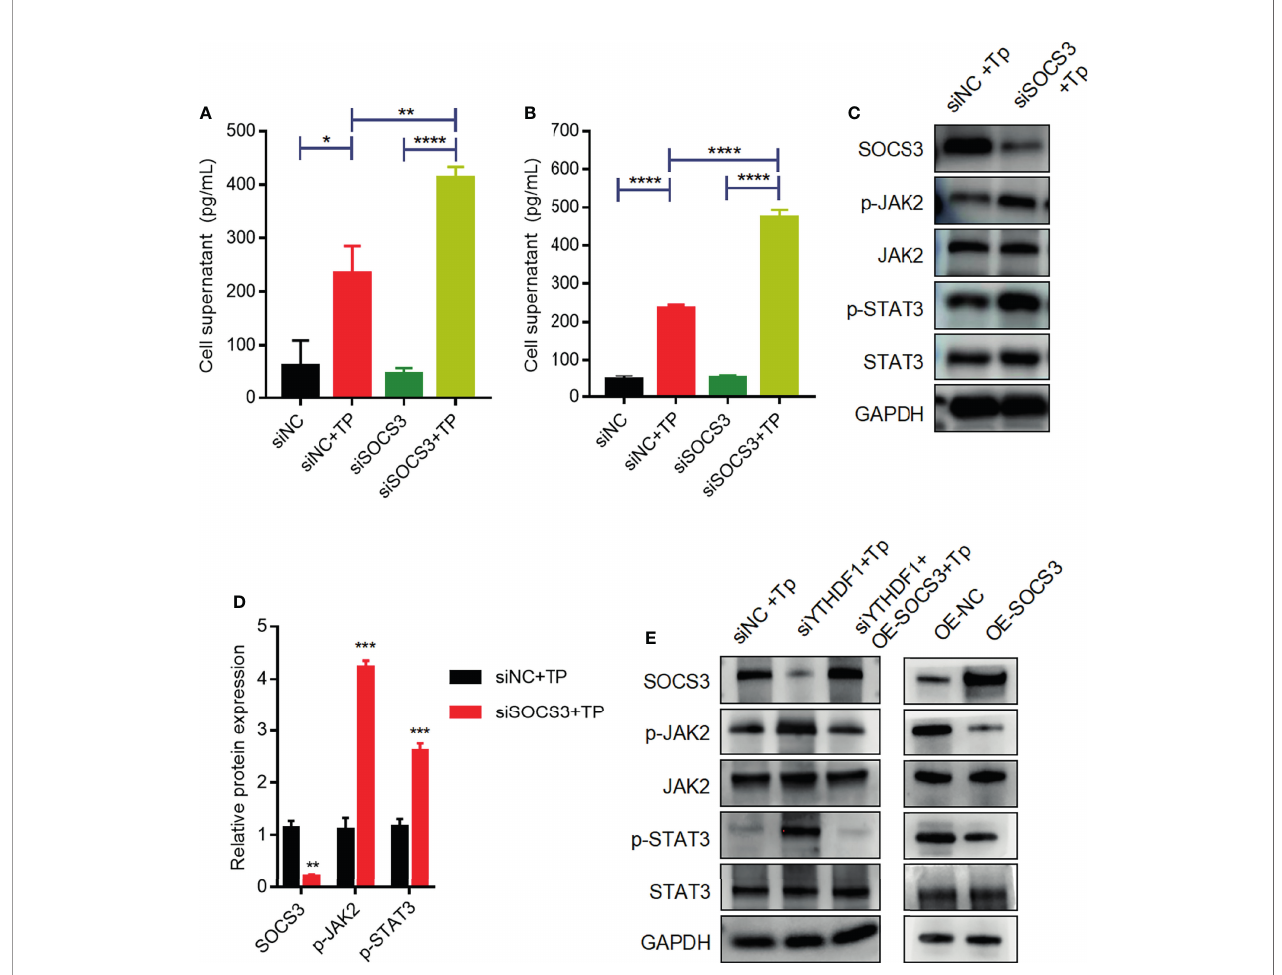
FIGURE 5 | SOCS3 suppresses in fl ammation in TP-infected macrophages via the JAK2-STAT3 pathway. (A, B) The concentrations of in fl ammatory cytokines (TNF- a and IL-1 b ) in the supernatants of THP-1 cells with or without TP infection following transfection with siNC or siSOCS3. (C, D) Western blot analysis of SOCS3, p- JAK2, JAK2, p-STAT3, and STAT3 in THP-1 cells transfected with siNC or siSOCS3. (E) Western blot analysis of SOCS3, p-JAK2, JAK2, p-STAT3, and STAT3 in piPSCs with or without YTHDF1 knockdown and transfected with control or SOCS3 plasmid. *P < 0.05, **P < 0.01, ***P < 0.001, ****P <